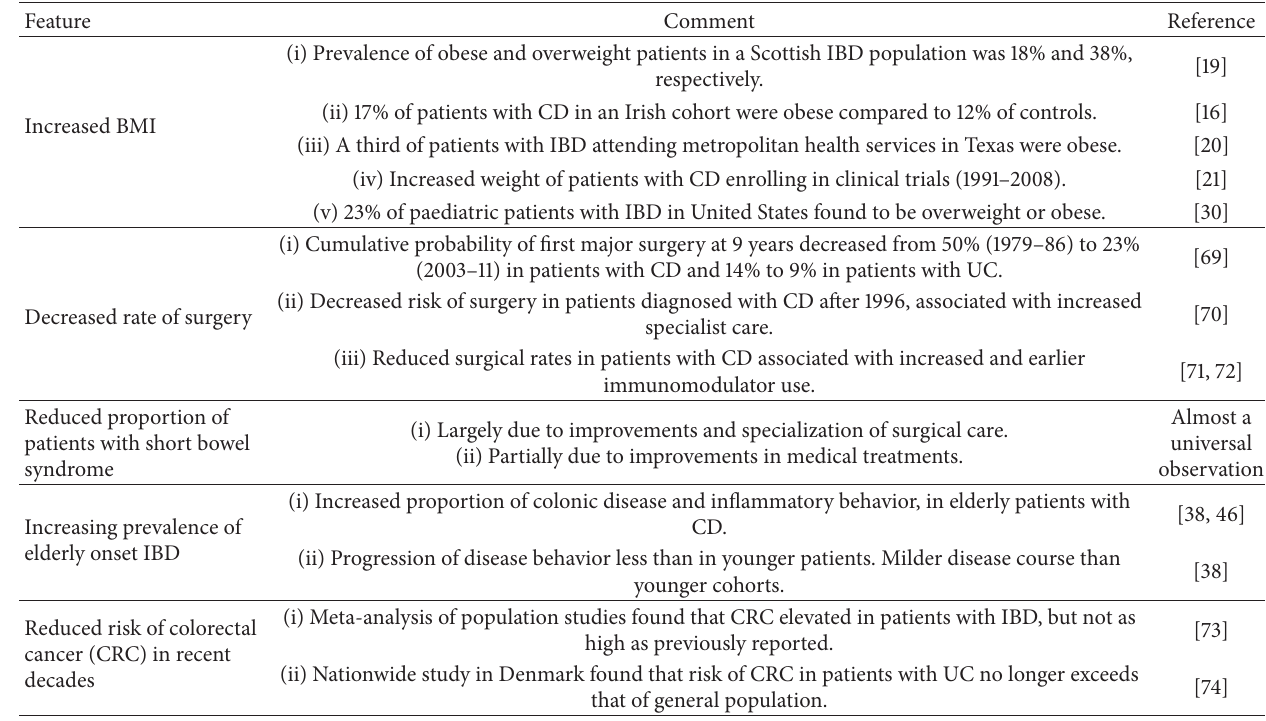
Table 1: The changing phenotype of patients with IBD [3].